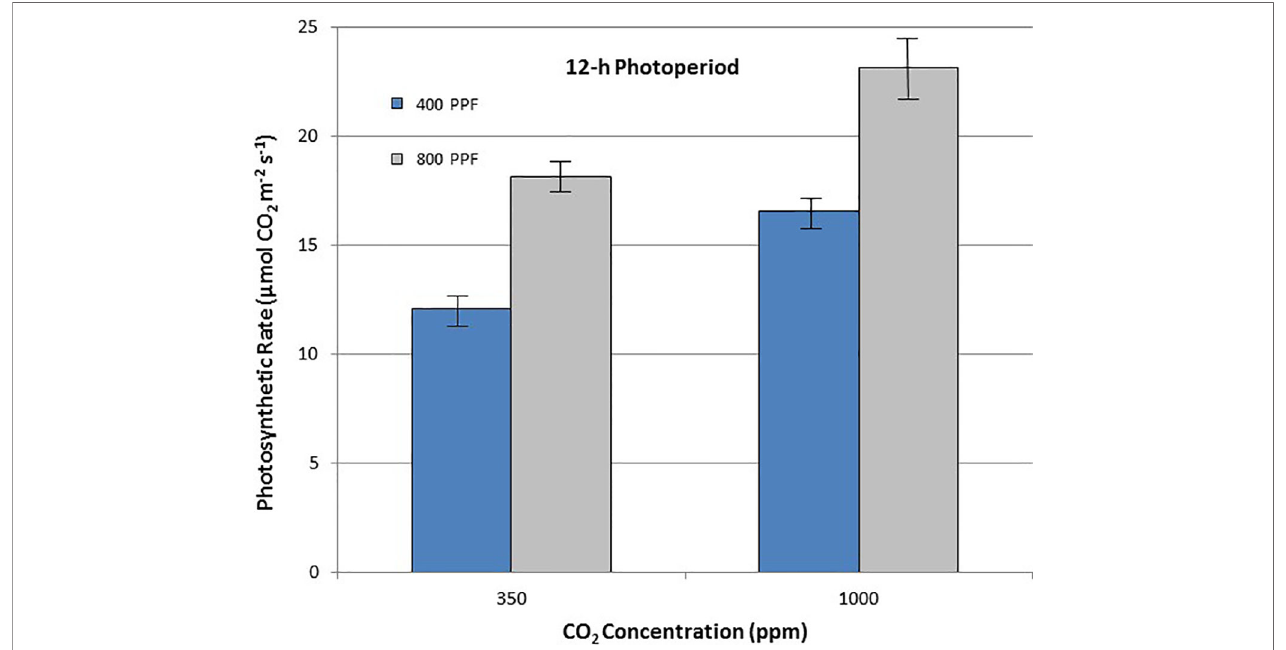
FIGURE 6 | Comparison of time-averaged leaf net photosynthetic rates taken at 21, 28, 35, 42, 56, 70, and 84 days after planting for all cultivars grown under a 12-h photoperiod at two [CO 2 ] concentrations, and two photosynthetic photon fl ux (PPF) levels. A total of n = 36 measurements were taken at each of the 7 dates, for a total 252 total measurements. Error bars indicate the standard error of the mean for average measurements at each date.